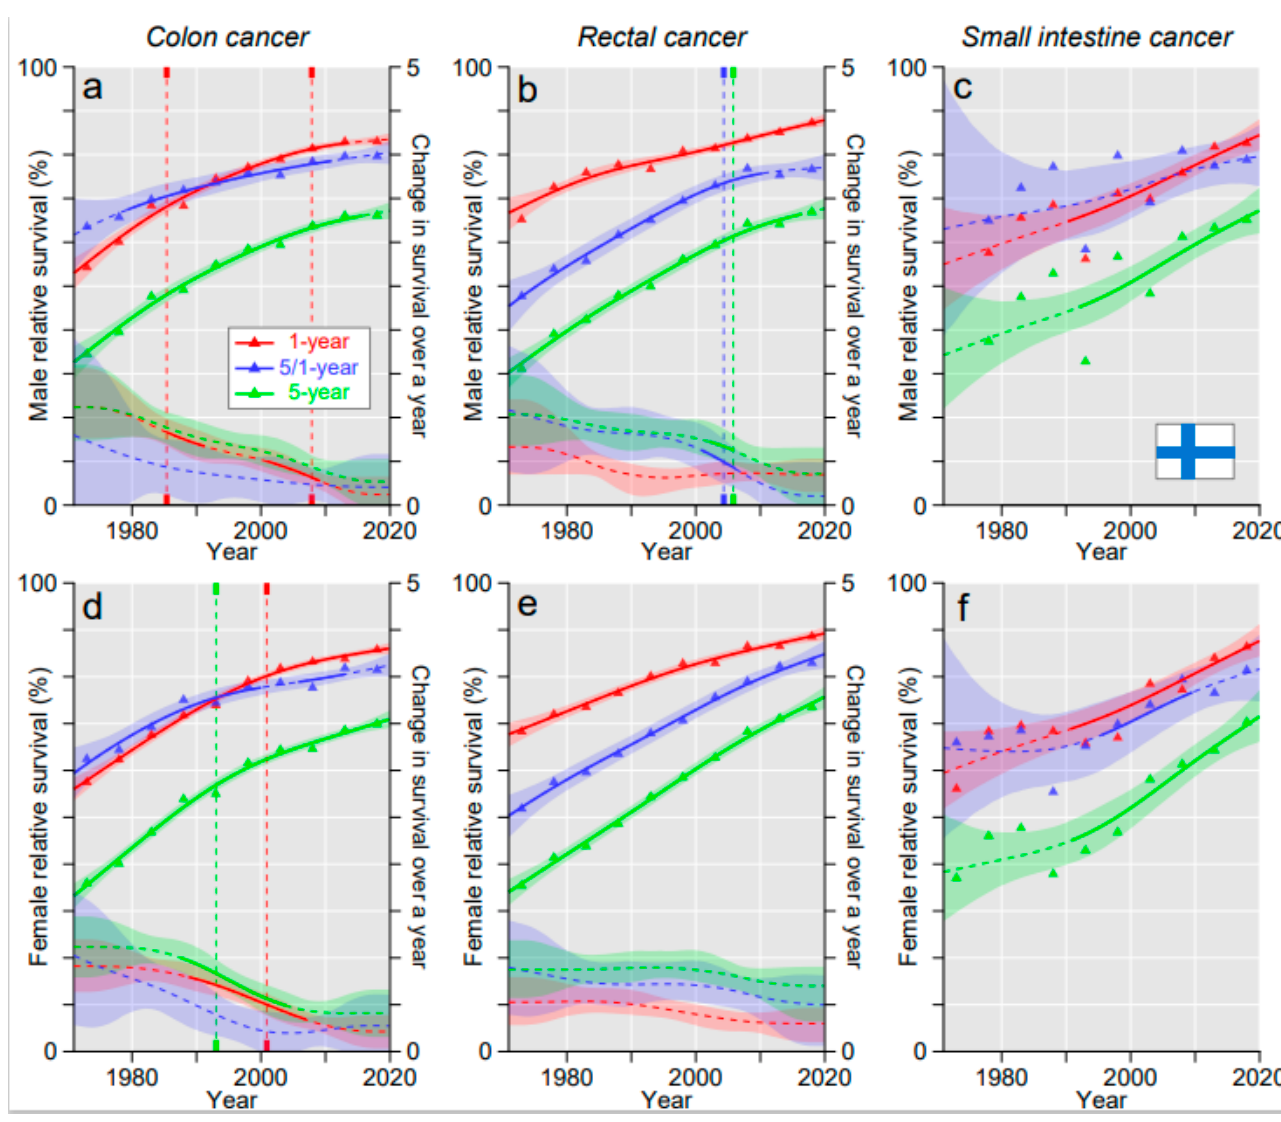
Figure 2. Relative 1- , 5/1- and 5-year survival in Finnish men ( a – c ) and women ( d – f ) in colon ( a , d ), rectal ( b , e ) and small intestinal cancers ( c , f ). The vertical lines show significant breakpoints in survival trends and bottom curves show estimated annual changes in survival. The solid lines in survival curves and annual change curve indicate a plausible trend (see Methods). All curves are color coded (see the insert).